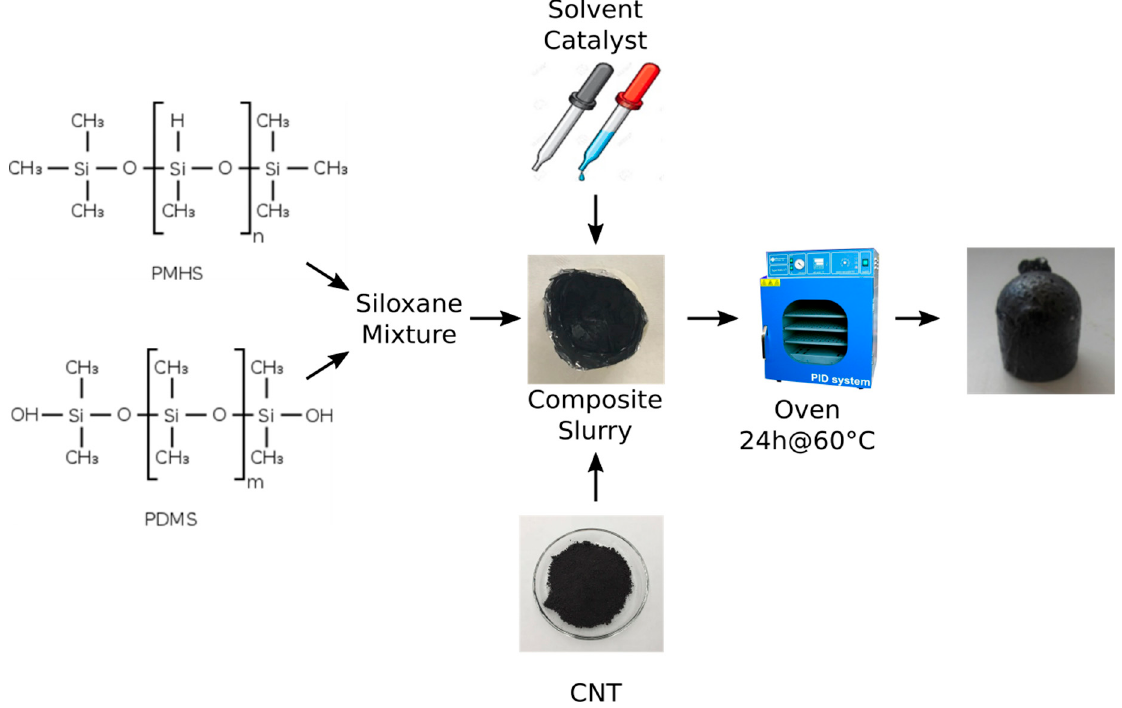
Figure 1. Scheme of the synthesis of the carbon nanotube composite foams.